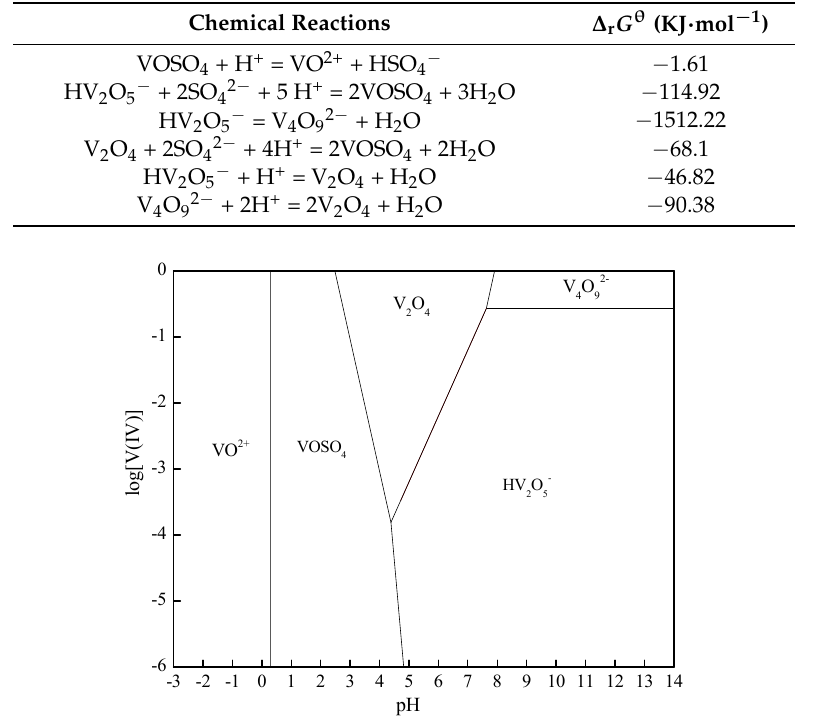
Figure 3. Activity-pH diagram for V(IV)-S-H 2 O system at 298.15 K (activity of sulfur 1.0).